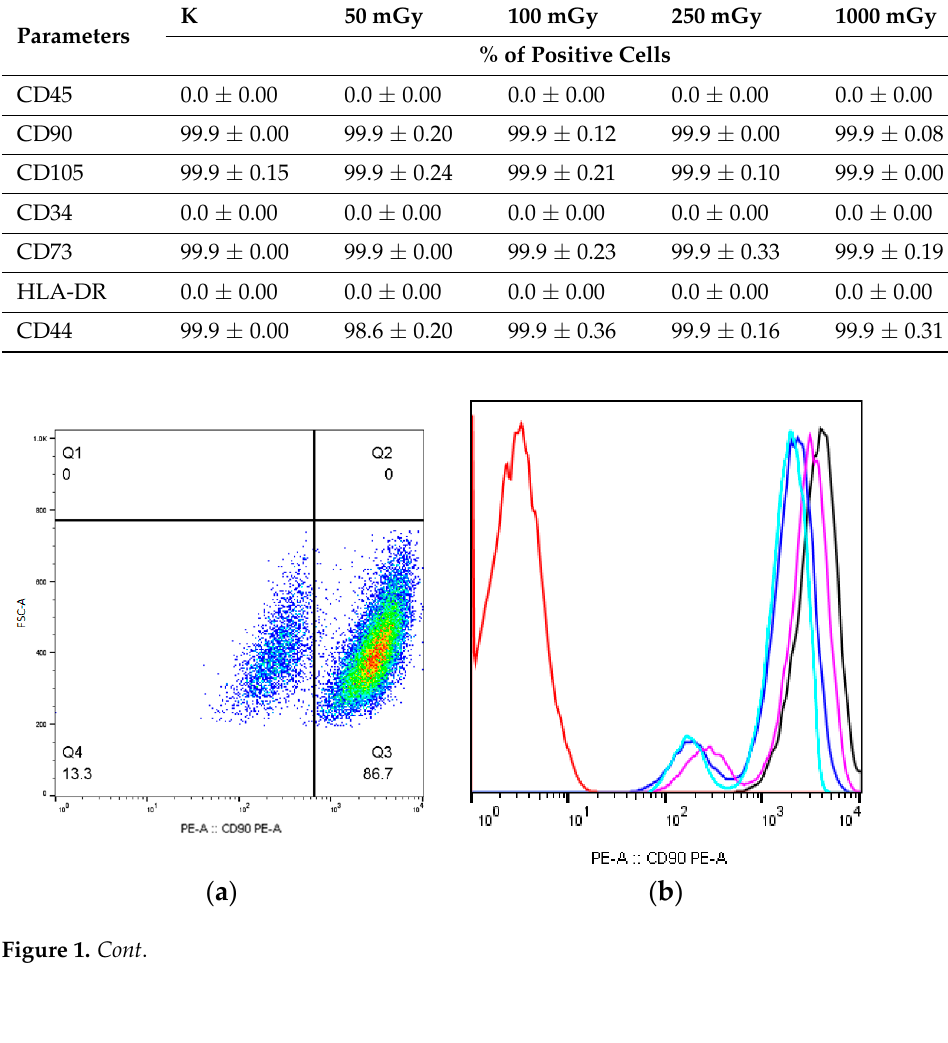
Table 1. The results of MSCs immunophenotyping 9 days after irradiation.